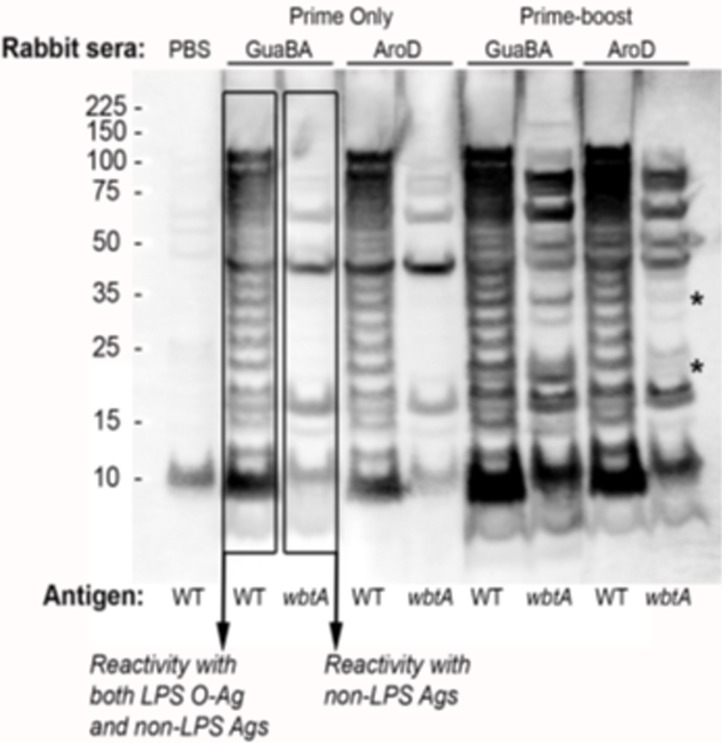
Differences in pre-challenge plasma antibody reactivity to Ft antigens between survivors and non-survivors of S4 challenge.Whole cell lysates of Ft LVS wildtype (WT) and the O-Antigen deficient LVS mutant (wbtA) grown in BHI broth were loaded into 9 wells of an SDS-PAGE gel prior to resolution and transfer to a nitrocellulose membrane. The membrane was reversibly stained with amido black and cut into 5 sections with 2 lanes/section. The sections were probed in parallel with the indicated 5 rabbit sera pools prior to simultaneous chemiluminescent development. Western blot immuno-reactivity with the bacterium’s LPS (which is decorated to varying degrees with O-Ag) resolved by SDS-PAGE typically reveals a characteristic LPS ladder pattern in WT Ft (left lanes for each vaccine) but not in Ft deficient for O-Ag such as wbtA (right lanes for each vaccine)[56–58]. * notes bands at ~35 and ~22 kDal that are different between the antibody response to S4ΔaroD and S4ΔguaBA.